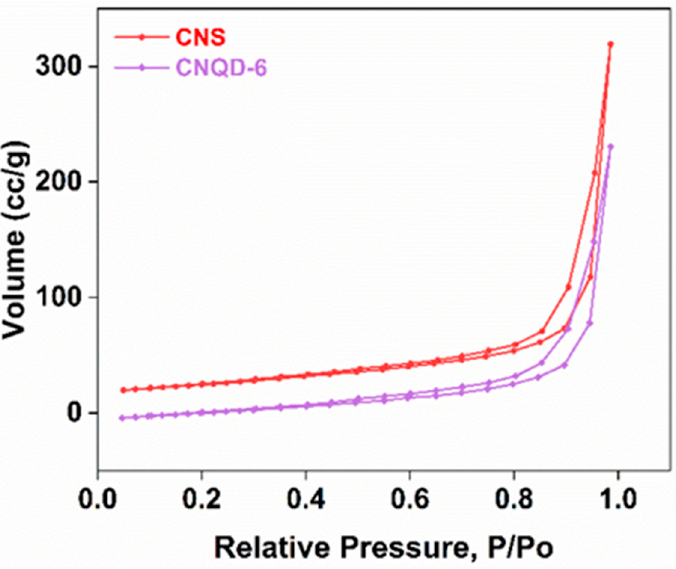
Figure 7. N 2 adsorption–desorption isotherms of CNS and CNQD-6 photocatalysts.